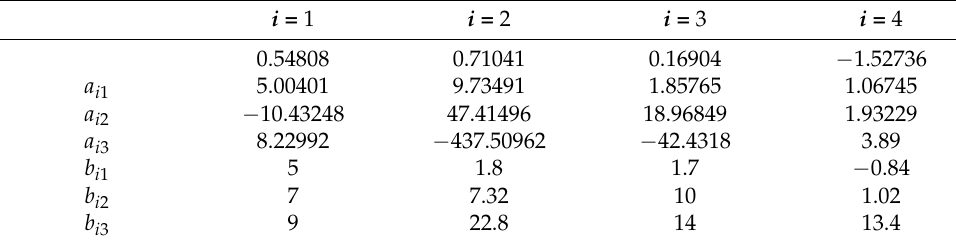
Table 1. Fitting coefficients in Equation (4).